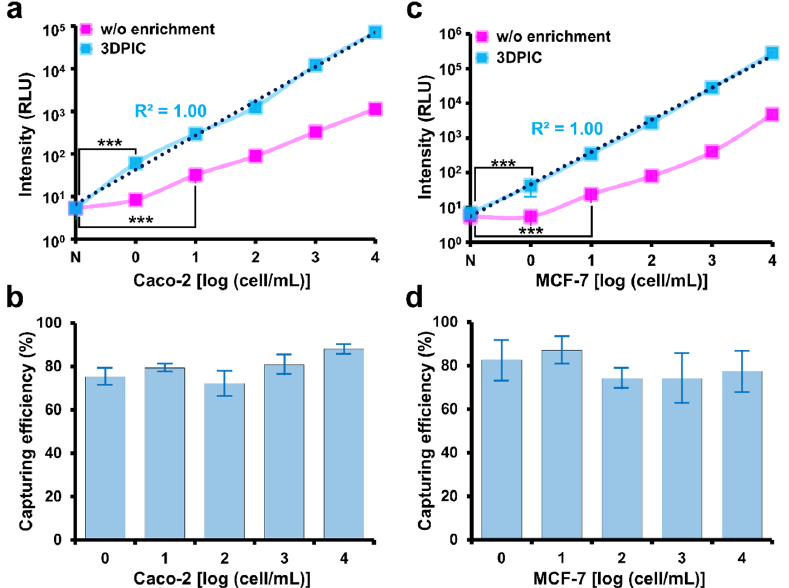
Figure 3. Isolation of cancer cells from PBS by 3DPIC and determination of the number of isolated cancer cells by the ATP luminescence assay. Number of Caco-2 ( a ) and MCF-7 ( c ) cells at different concentrations (1–10 4 cells/mL, final conc.) in 10 mL of PBS determined by the ATP luminescence assay with and without 3DPIC. Capturing efficiency of Caco-2 ( b ) and MCF-7 ( d ) cells at different concentrations (1–10 4 cells/mL, final conc.) in 10 mL of PBS by 3DPIC. Student’s t -test, *** p < 0.001, n = 3.